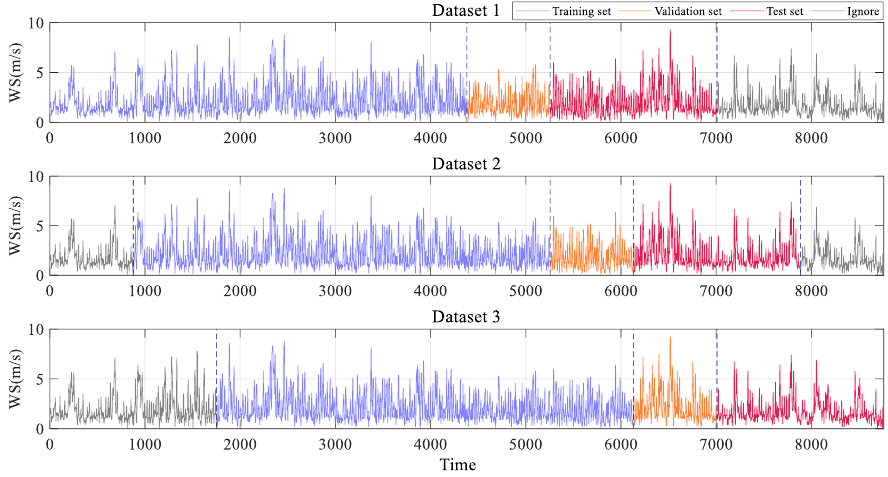
Figure 4. Schematic diagram of data set division .